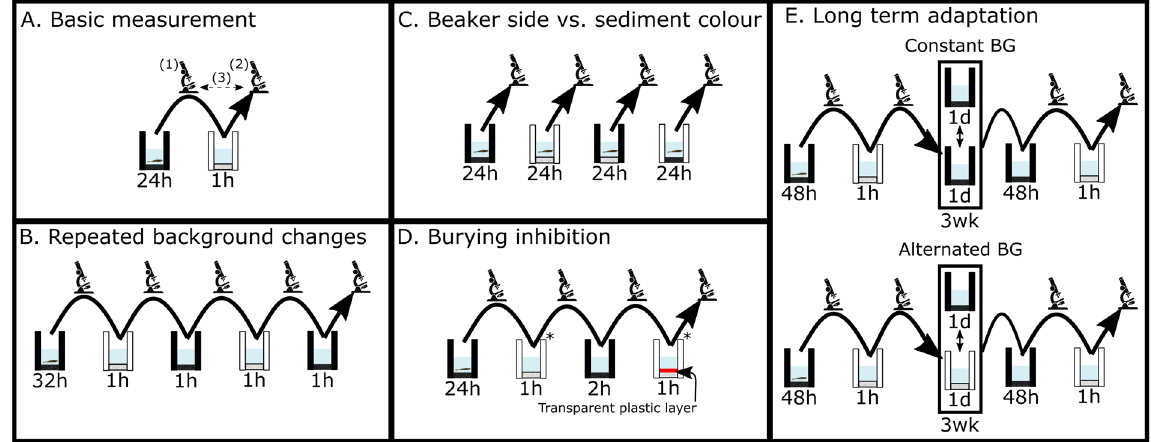
Figure 2. Schematic overview of the different protocols to determine the factors involved in Crangon crangon background matching. Arrows indicate shrimp being moved between beakers with different backgrounds, or to a dissecting microscope (microscope symbol) for pigment coverage measurements. Black and white colours indicate the colour of the sediment (bottom) and sides of the beaker. Time spent in each beaker is given below the beaker symbol. Repeated measurements with the same shrimp are indicated with continuous arrows. (1) First photo, (2) second photo, (3) colour change, * order randomly